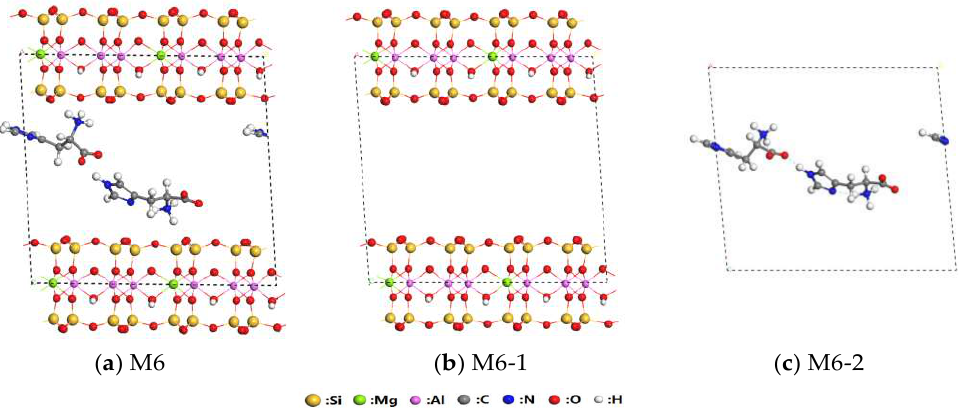
Figure 4. Structural models of histidine-intercalated MMT; ( a ): histidine-intercalated MMT structure; ( b ): MMT lamellas structure; ( c ): histidines structure in M6.